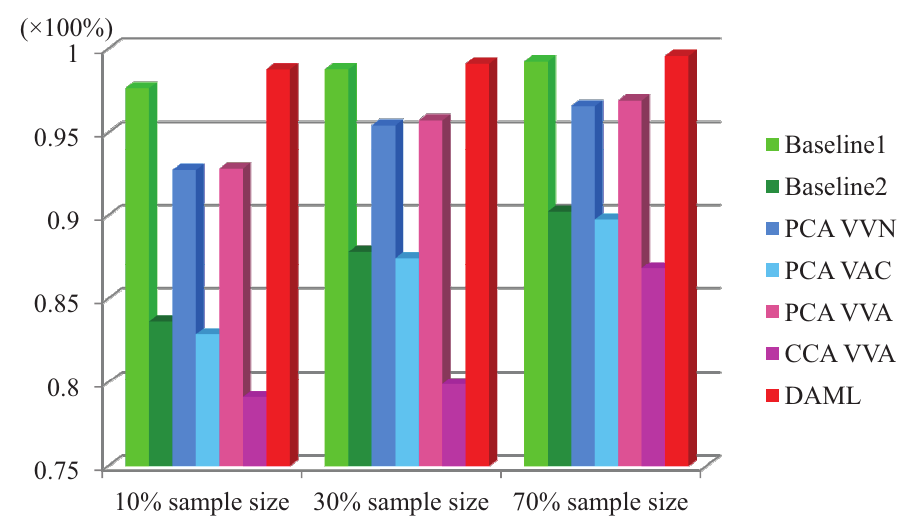
Figure 6. Average classification accuracies under different training sample size